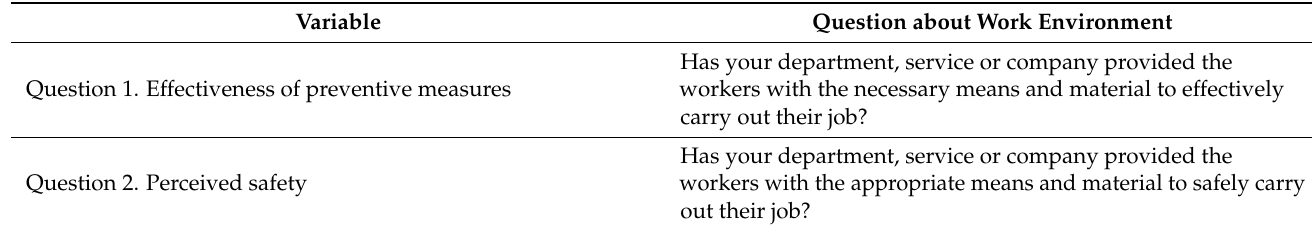
Table 1. Questions about the work environment in relation to the